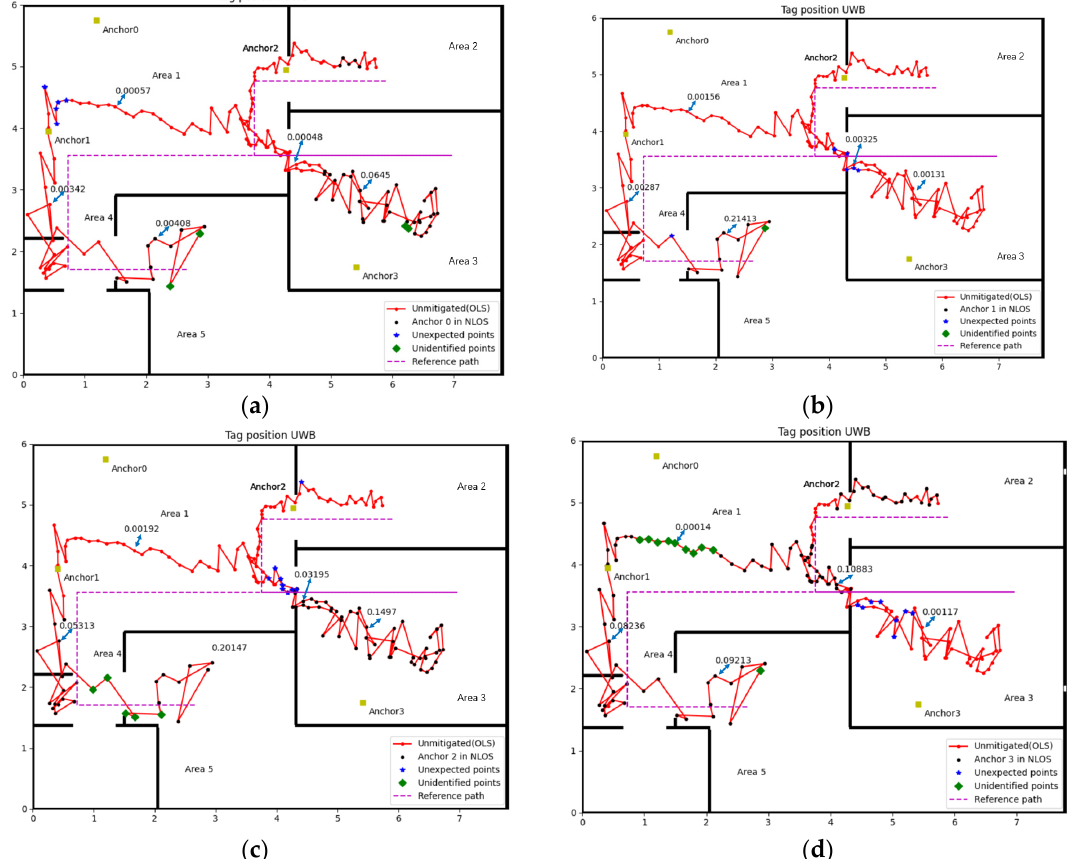
10 of 19 Table 1. Anchors in NLOS in different Areas.